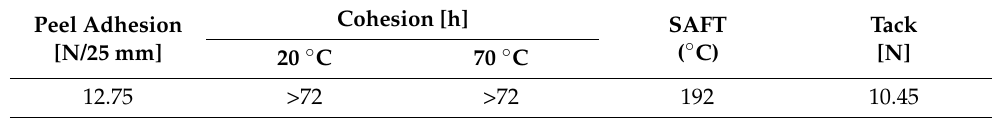
Table 3. Q2 7358 pressure-sensitive adhesive results without